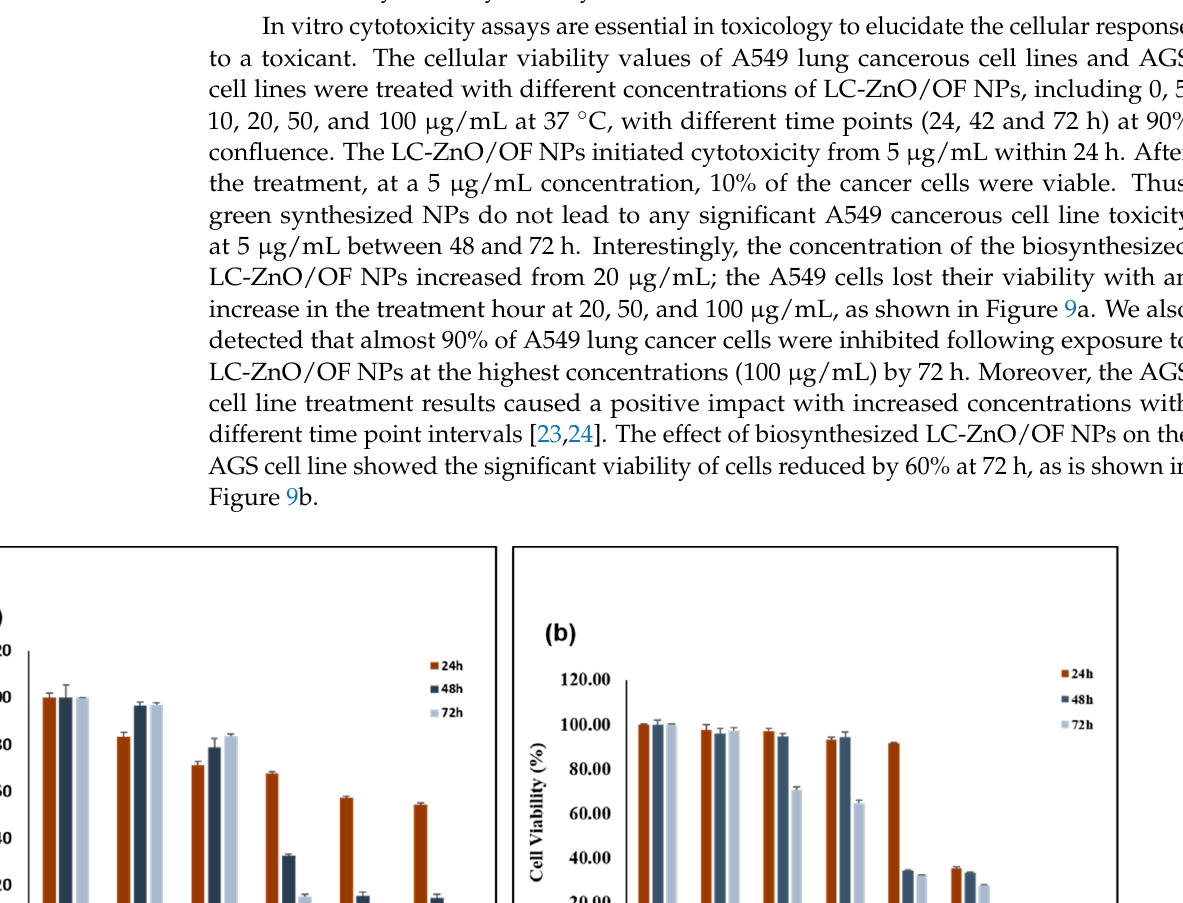
Figure S2: The UV–visible and FE-Tem analysis of ZnO NPs (without Lycium ), Figure S3: Compari- son photocatalytic study of Lycium ZnO NPs, Lycium Extract and ZnO NPs (without Lycium ) in both